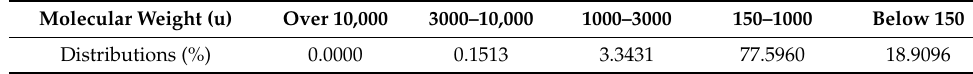
Table 3. Molecular weight distributions of corn oligopeptides.